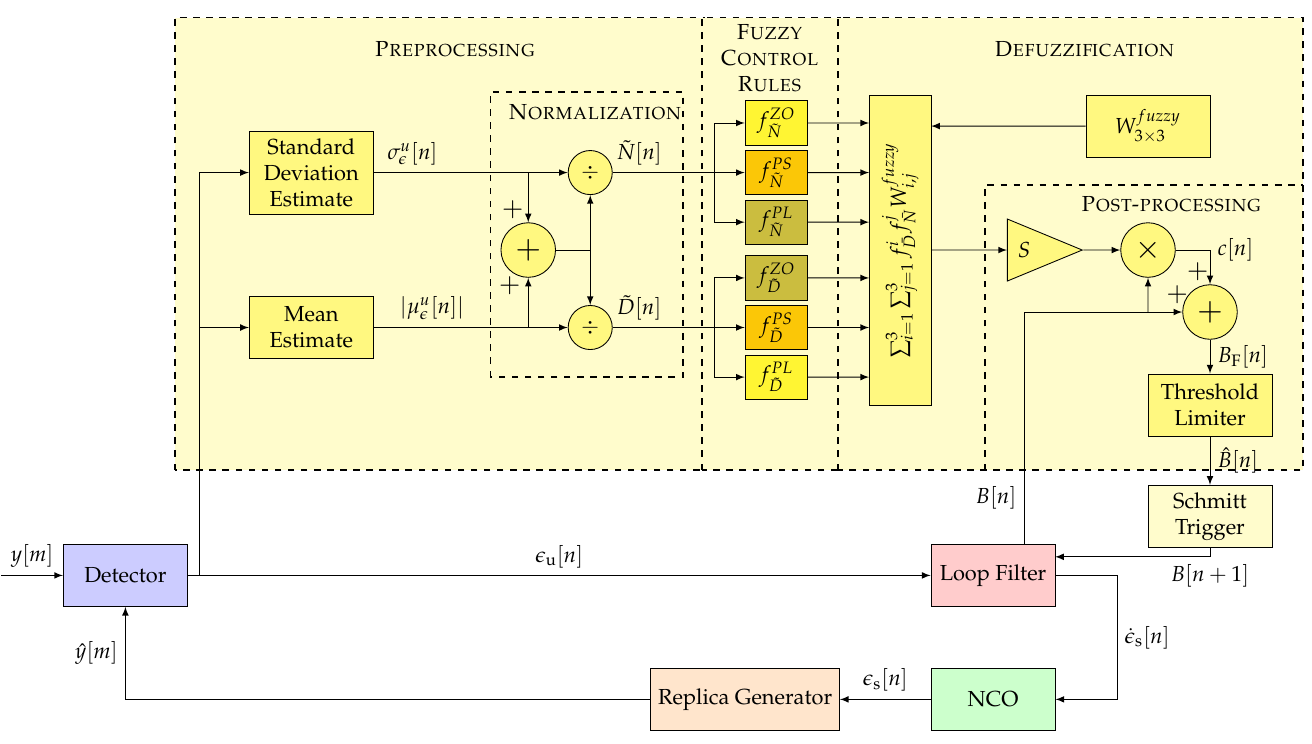
Figure 7. Architecture of implemented Fuzzy Logic (FL) technique. ©IEEE. Adapted, with permission, from [7]. Next, the fuzzy control rules are applied. The zero f ZO , the positive-small f PS and